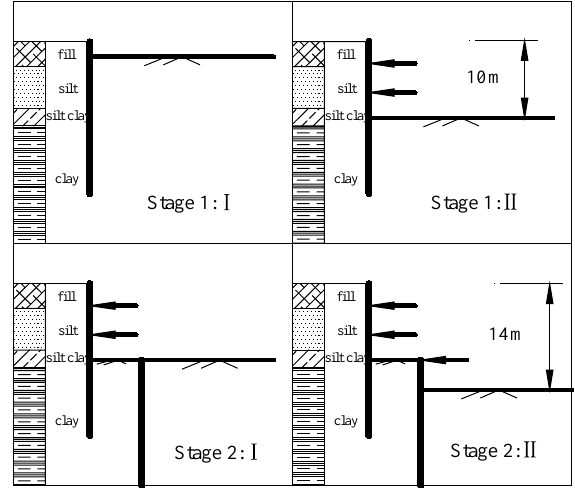
Fig. 3. Subsurface conditions and excavation sequence